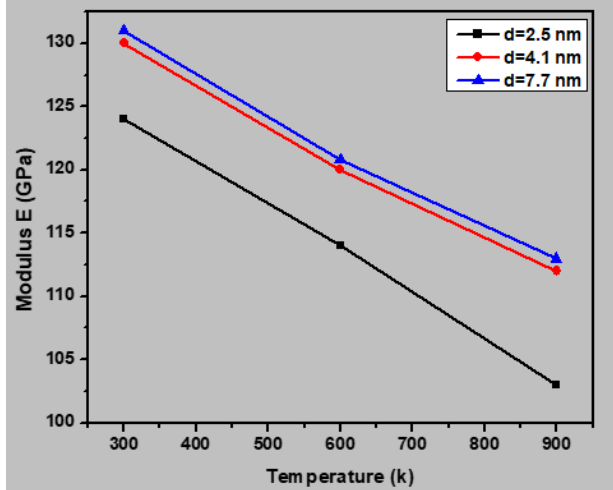
Figure 12. Young’s modulus of the nanocrystalline stainless steel samples with average grain sizes of 2.5, 4.1, and 7.7 nm with respect to temperature.